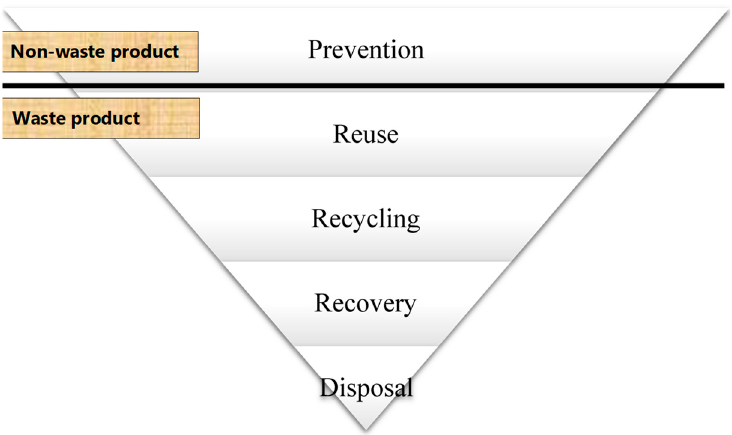
Figure 3. Hierarchy of